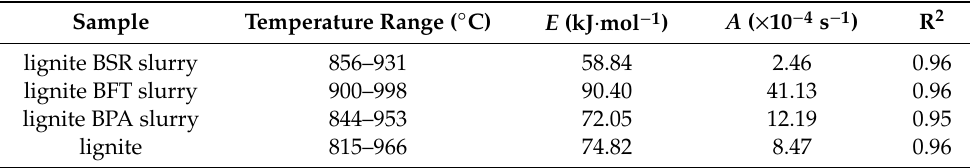
Figure 9. Arrhenius diagram of slurry fuels and coal sample. Table 5. Activated energy of samples.